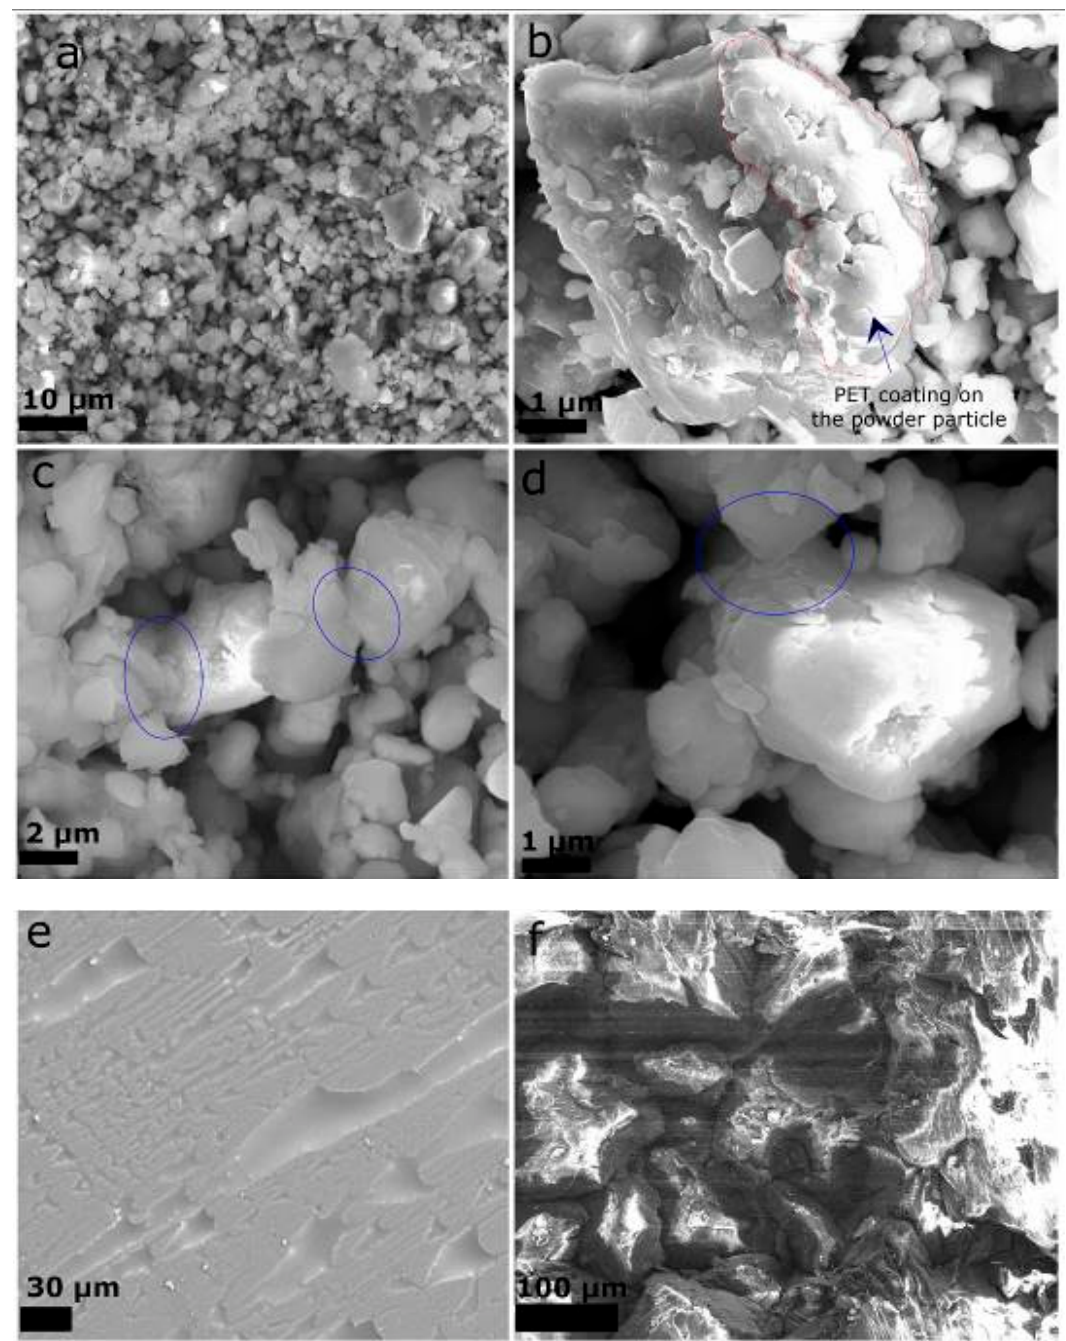
Figure 4. SEM images of the obtained samples: Surface of the composite sample Al 85 Y 8 Ni 5 Co 2 + PET (1%) obtained by SPS ( a ), the particle coated by PET ( b ), neck formations between some of the particles during SPS process ( c , d ), surface of the Al 85 Y 8 Ni 5 Co 2 ribbon sample ( e ), and polyethylene terephthalate bulk sample ( f ).